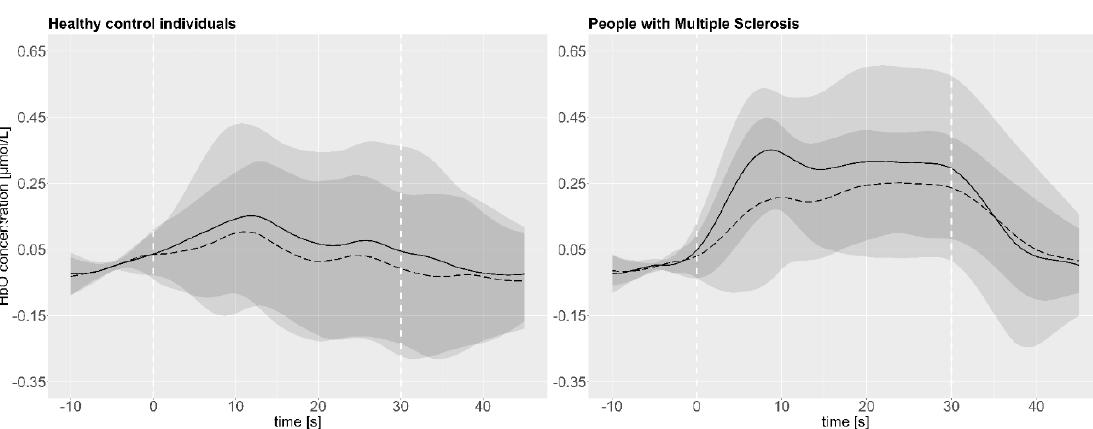
Figure 3. Mean cHbO test (continuous line) and retest (dashed line) data and their respective standard deviation (test: light grey / retest: dark grey) of the lDLPFC46 over all subjects over the entire course of the measurement; 30 s walking interval is indicated by the white dashed lines.